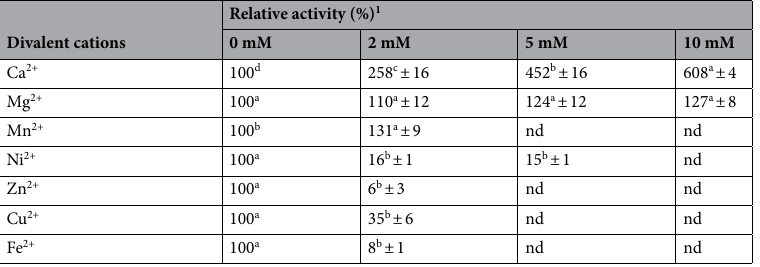
Table 1. Effect of divalent cations on PsFucS1 activity. nd not determined. 1 Data are given as averages of duplicate determinations in each row in this Table. Different roman superscript letters a–c indicate statistically different values at p < 0.05 for different addition levels of each cation.